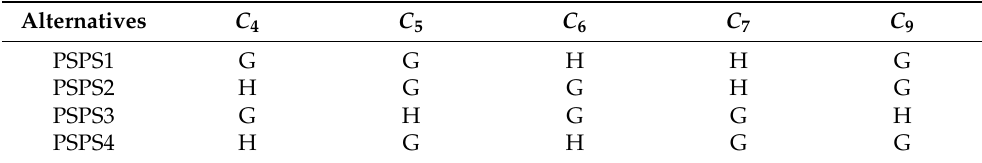
Table 3. Linguistic terms for every qualitative sub-criterion given by expert panel. Alternatives C 4